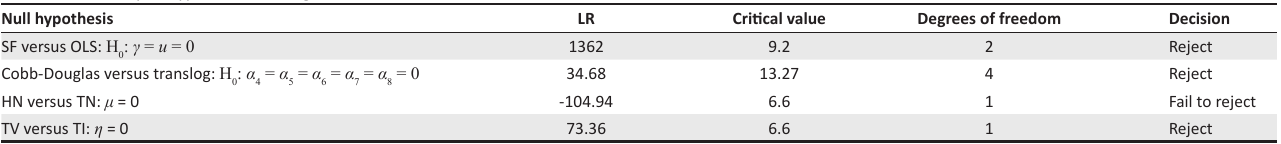
TABLE 3: Summary of hypotheses